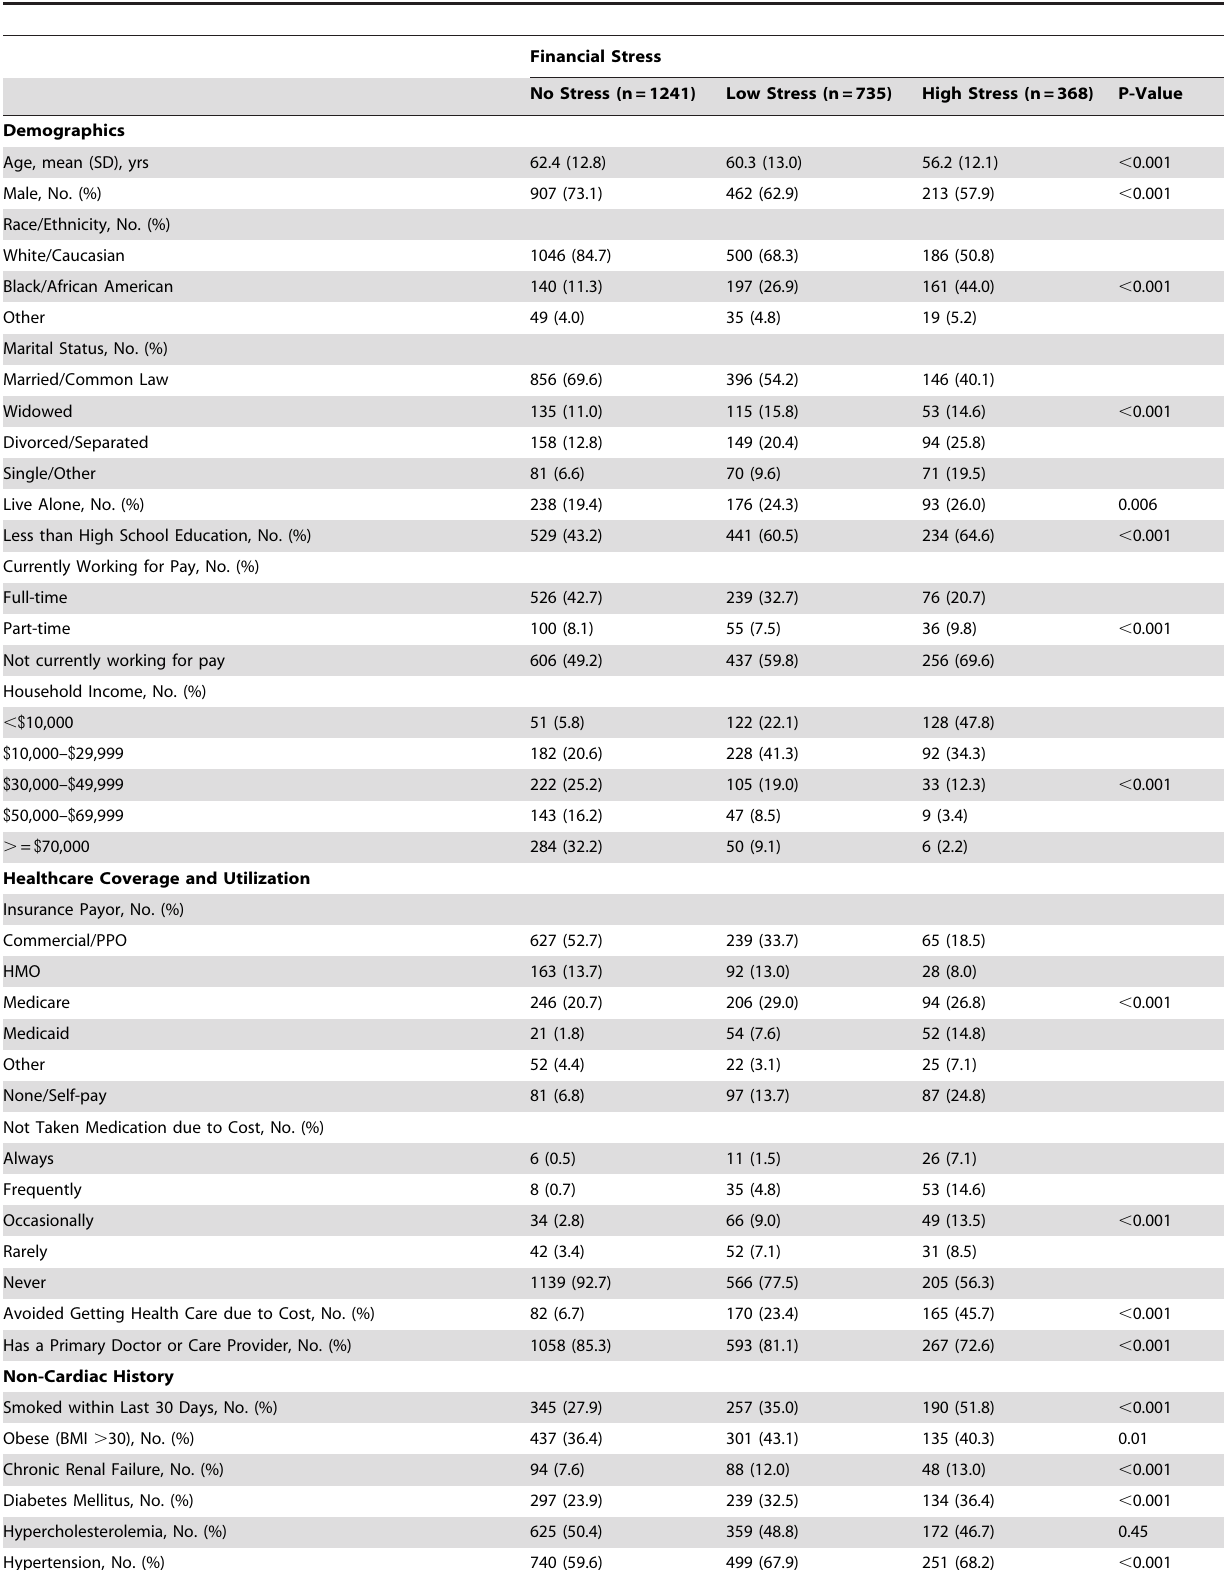
Table 1. Baseline Characteristics of Patients Admitted for Acute Myocardial Infarction, Stratified by Patient Reporting of Financial